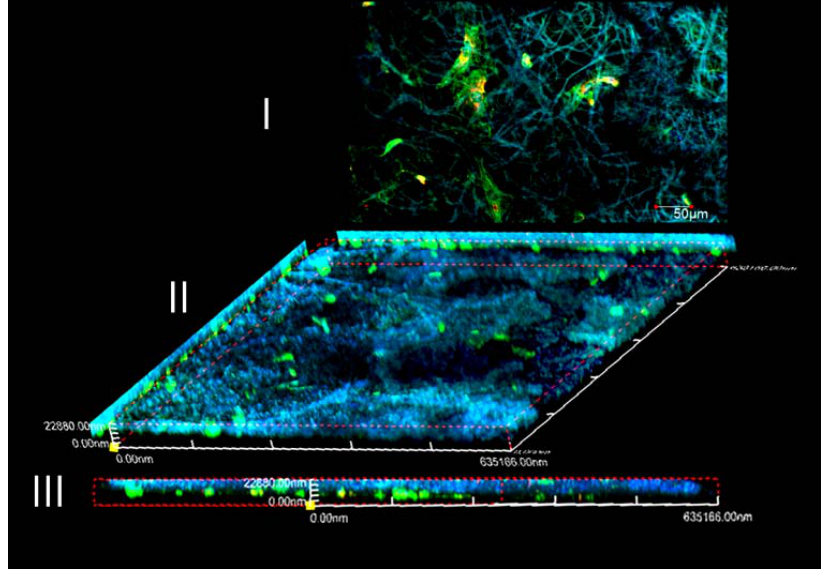
Figure 12. Fluorescent staining of F-actin (green), vinculin (red), and cell nuclei (blue) for MC3T3-E1 cells after 24 h cultivation on silk/nHA fibrous scaffold. ( I ) 2D morphology of cultivation; ( II ) 3D morphology by laser scanning of fibrous scaffold; and ( III ) cross section of